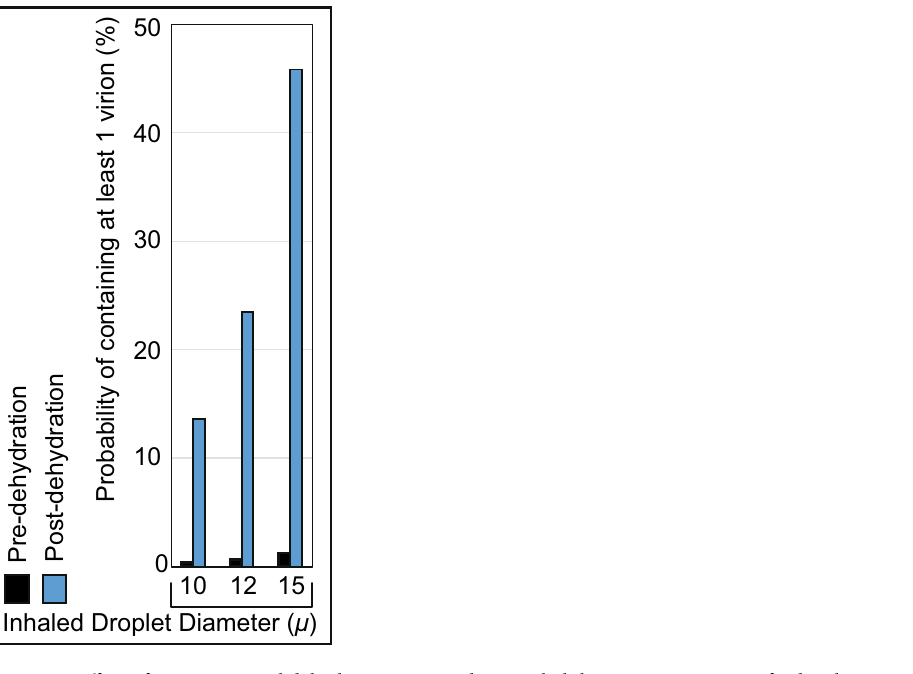
Figure 6. Effect of environmental dehydration assessed via probabilistic interpretation of a droplet to contain at least 1 virion, based on whether the droplet size at inhalation is pre-dehydration or post-dehydration. The plots are generated using Microsoft Excel 365; link to softw are homep